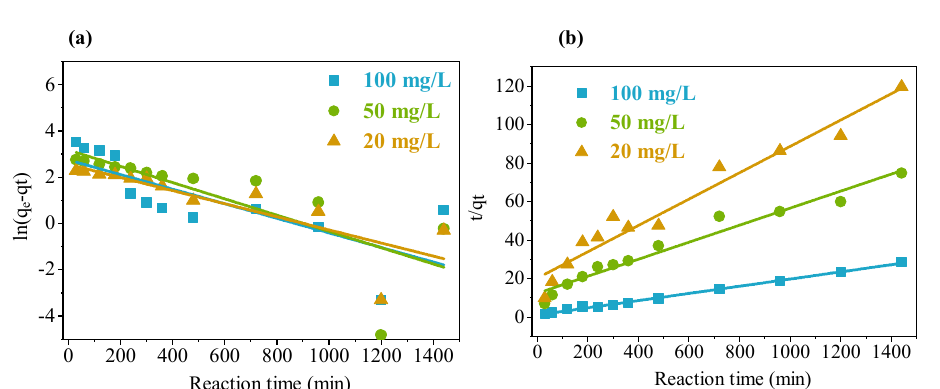
Figure 6. Fitting model for the Cr(VI) adsorption: The pseudo–first–order model ( a ), and the pseudo–second–order model ( b ).